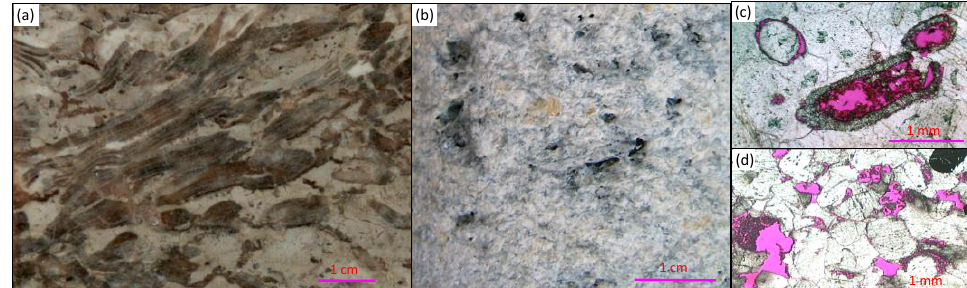
Figure 5. Photographs of the carbonate matrix reservoirs. ( a ) stromatoporoid reef limestone, T243, 4473.93 m, core; ( b ) dissolution vugs in the bioclastic limestone, T62, 4755.5 m, core; ( c ) intragranular dissolution pores in bryozoa fragment, T54, 5757.83 m, casting thin section; ( d ) intergranular dissolu- tion pores in bioclastic rock, T62, 4751.2 m, casting thin section (pink-dye resin showing